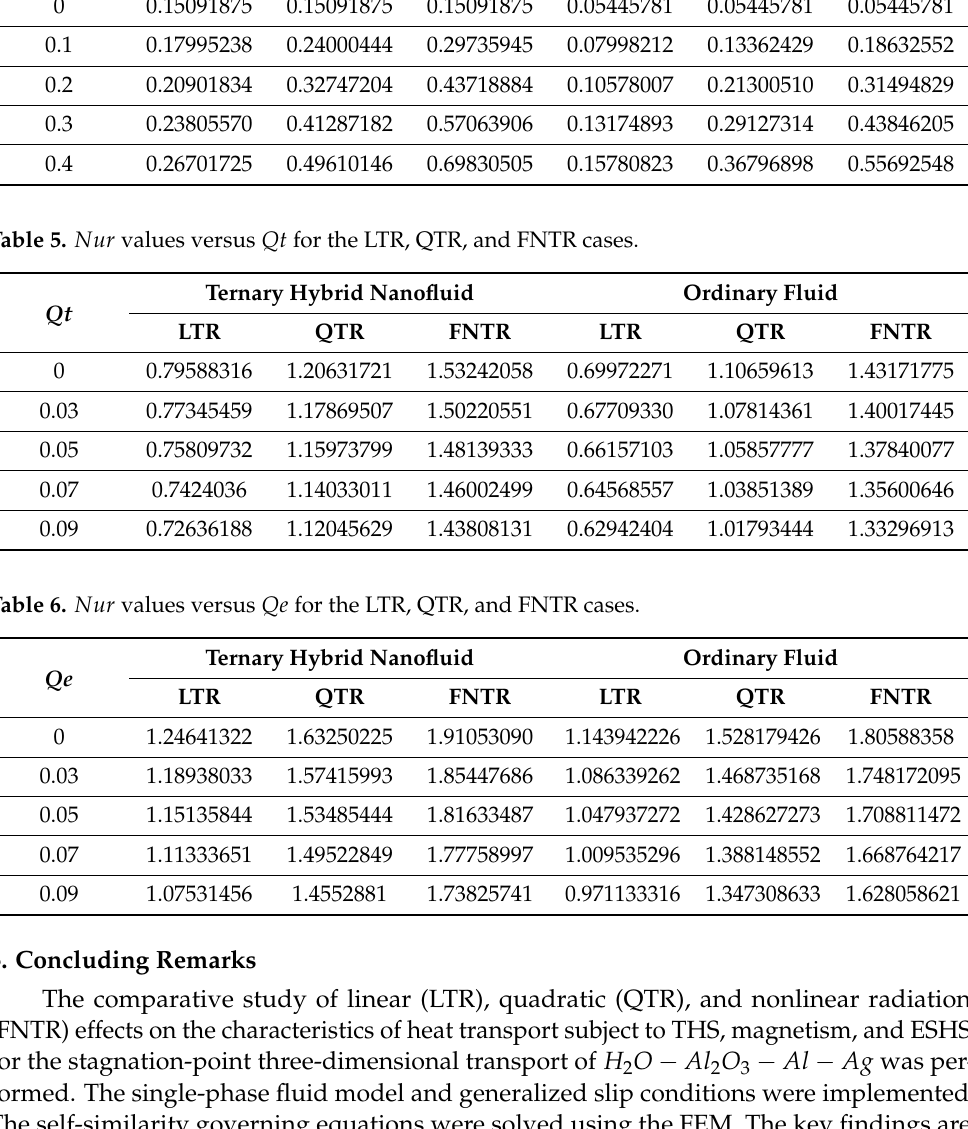
Table 4. Nur values versus Rd for the LTR, QTR, and FNTR cases. Rd